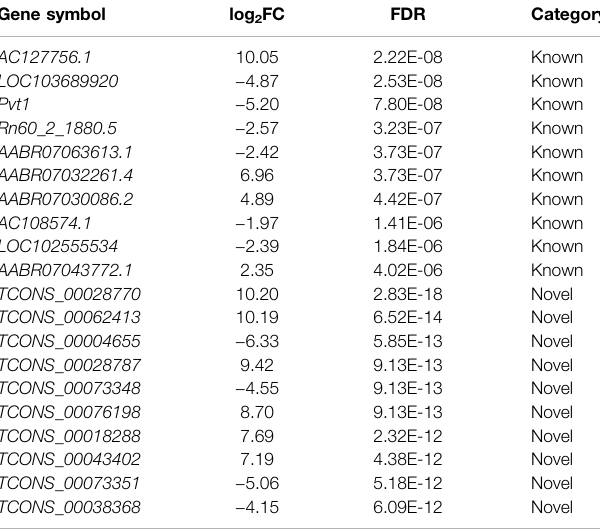
FC,thefoldchangeofmechanicalstresscomparedtocontrol.FDR, p -valueadjustedby the Benjamini – Hochberg method. FDR < 0.05 was considered statistically signi fi